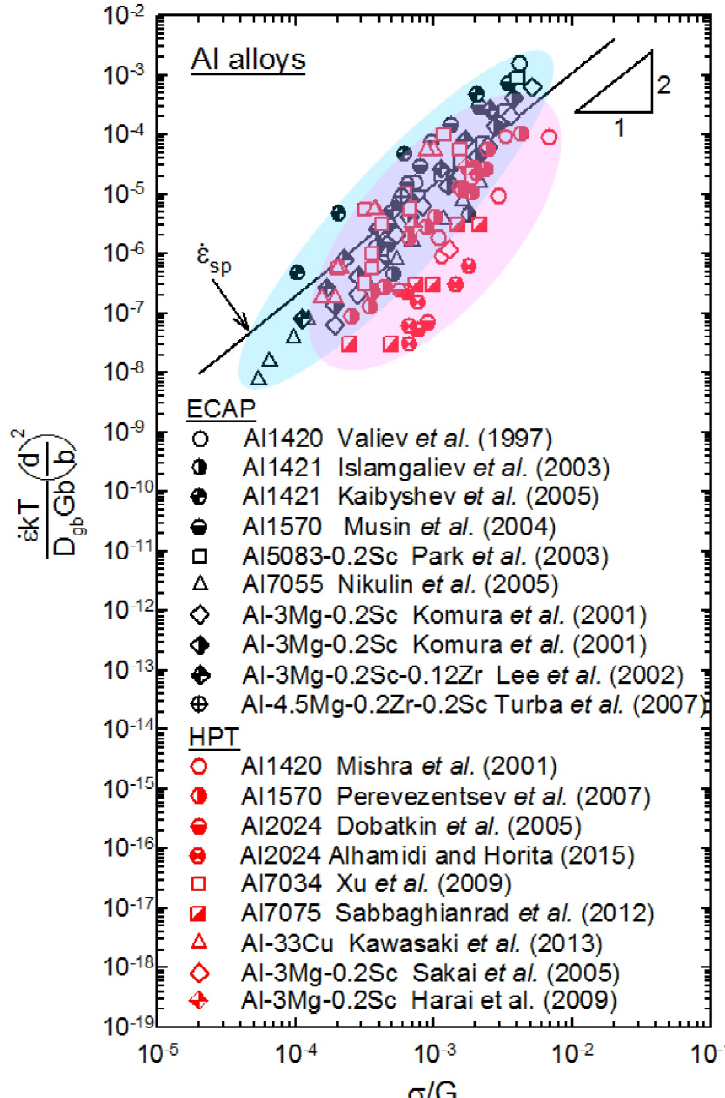
Fig. 5. A compilation of data for a series of UFG Al alloys [29] after ECAP [30-39] and HPT